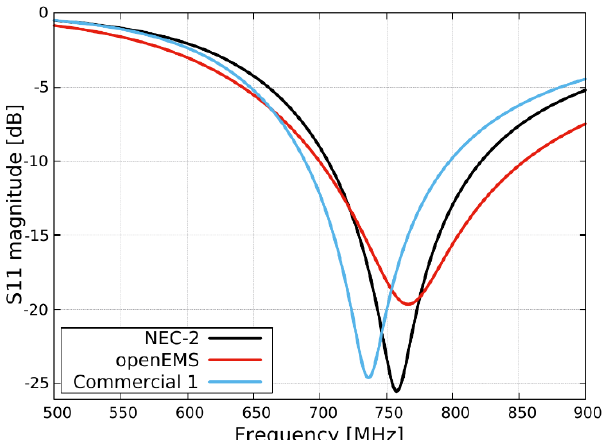
Fig. 12. Magnitudes of the reflection coefficients of the BiQuad antenna, as obtained by openEMS, nec2c, and a commercial code. Red line: OpenEMS; Black line: nec2c. Blue line: commercial code